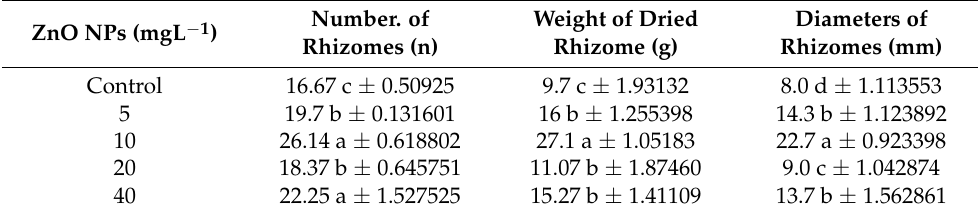
Table 2. Zinc oxide nanoparticles (ZnO NPs) impact the number (n) of rhizomes, rhizomes dried weight, and rhizome diameter (mm) of C. longa . Mean values followed by the same letter within a column are not significantly different at p = 0.05, as measured by Duncan’s test. Number. of